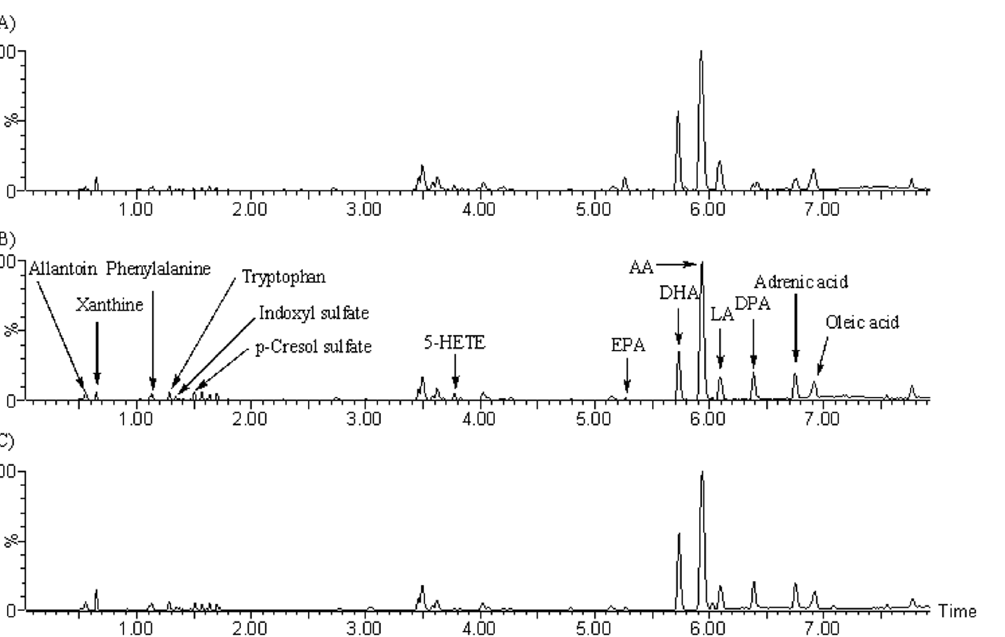
Fig. 2. The UPLC-MS base peak intensity (BPI) chromatograms. (A) control group, (B) CKD group and (C) CKD + Ergone group. The chromatogram showed identified